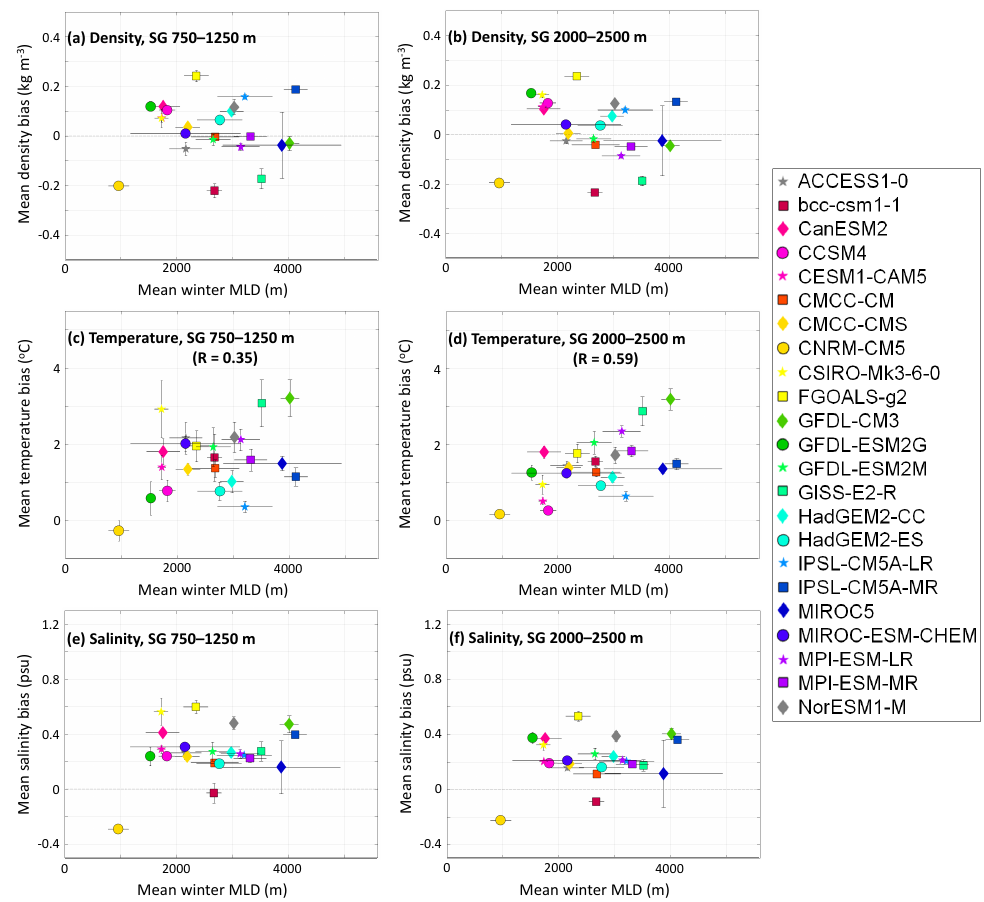
Figure 2. Across-model relationship between the 20-year mean density (a, b) , temperature (c, d) and salinity (e, f) bias at the two depth levels representative of NADW (columns) and the 20-year mean winter MLD, in the subpolar gyre